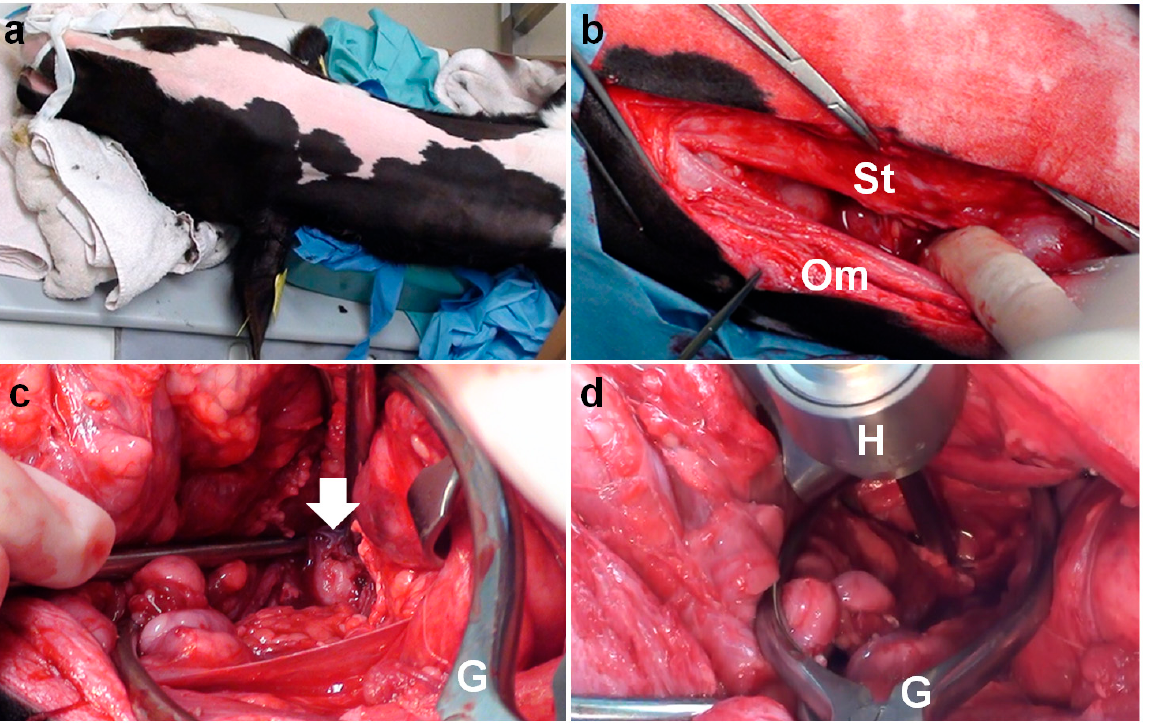
Figure 3. ( a ) Intraoperative photos of ventral bulla osteotomy in Case 1, positioned in dorsal recumbency with the neck extended. ( b ) The sternothyroid (St) and omohyoid (Om) muscles are separated under the area of a 15 cm incision. ( c ) The ventral surface of the tympanic bulla (arrow) is seen as a rounded, irregular structure at the deepest area of the surgical opening, extended using a Gelpi retractor (G). ( d ) A hand chuck (H) is used to perforate the tympanic